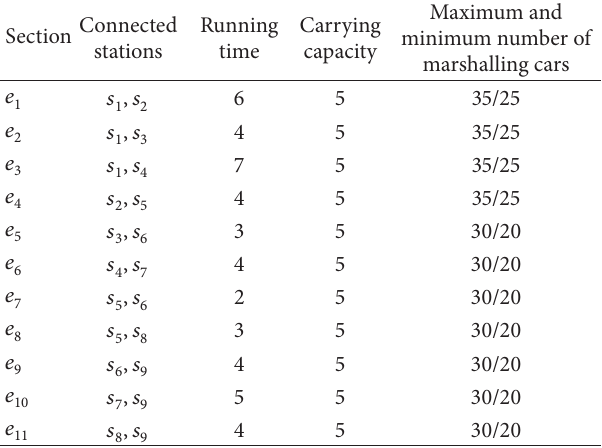
Table 2: Running time, carrying capacity, and requirement number of train marshalling cars of each section.